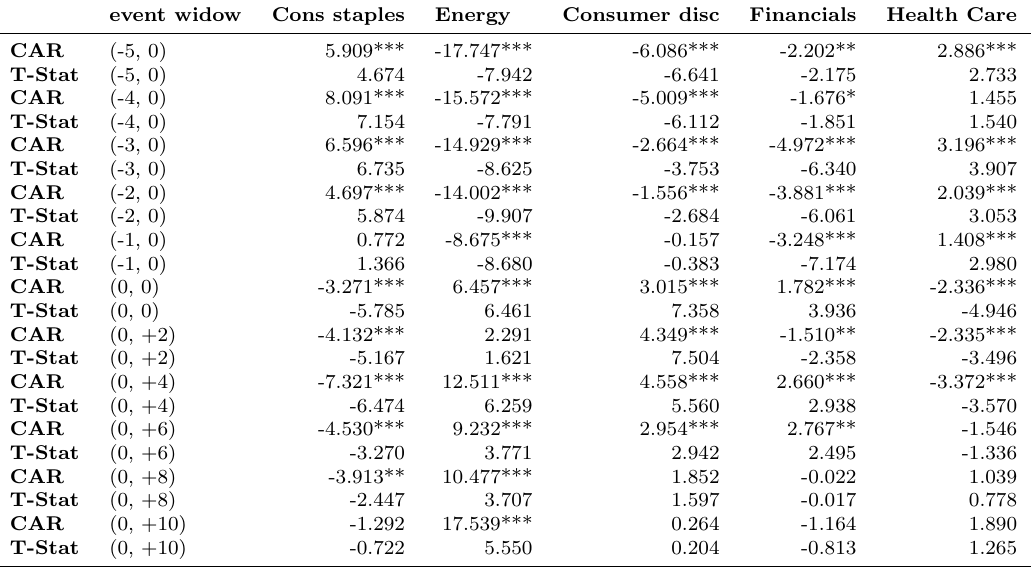
Table 5: Event 3 19-03-2020 First Order of ”Stay at